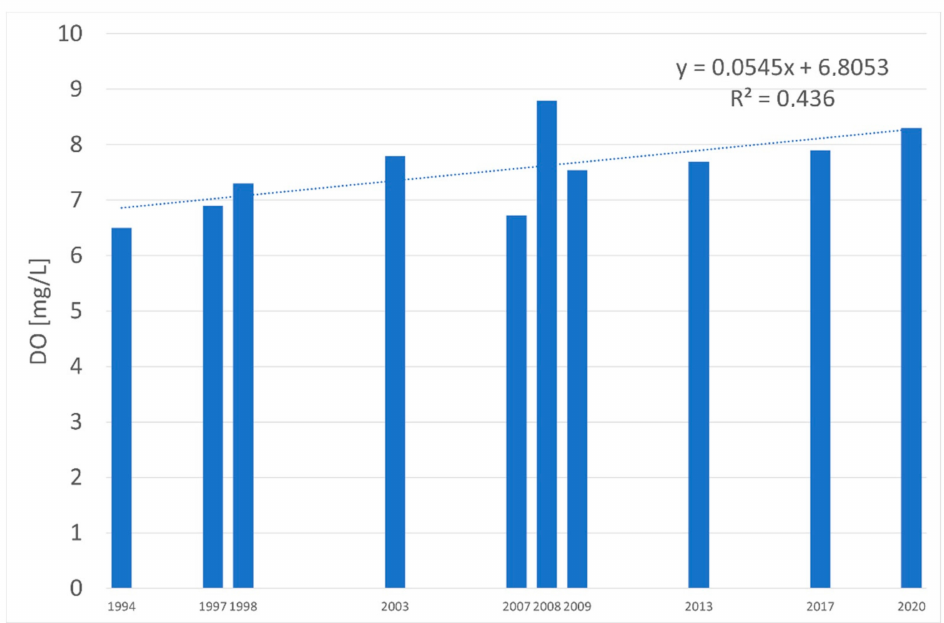
Figure 7. Changes in oxygen concentration (DO) and the trend line in the Vistula in the period from 1994 to